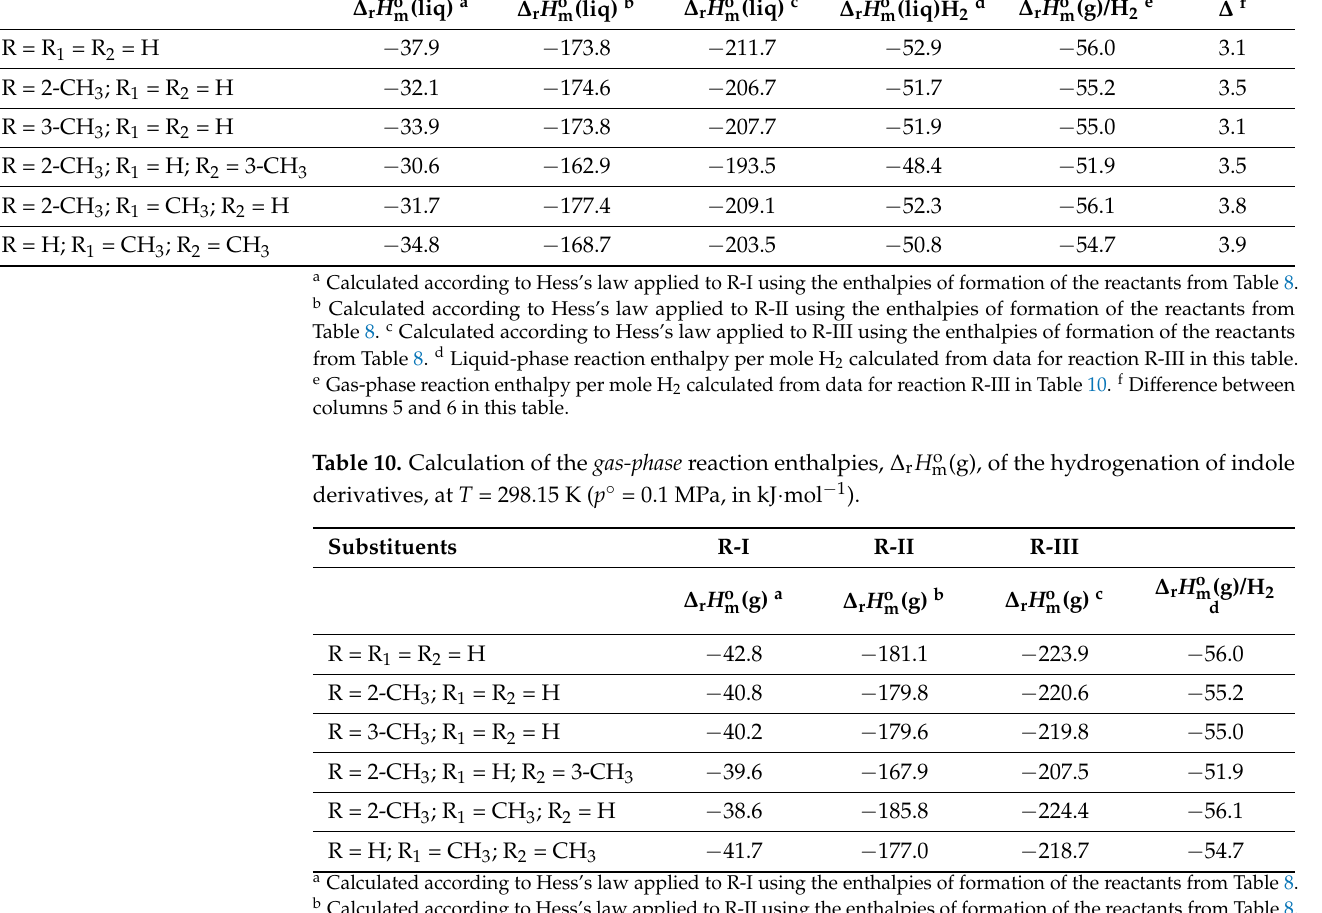
Table 9. Calculation of the liquid-phase reaction enthalpies, ∆ (cid:2928) 𝐻 mo (liq), of the hydrogenation of indole